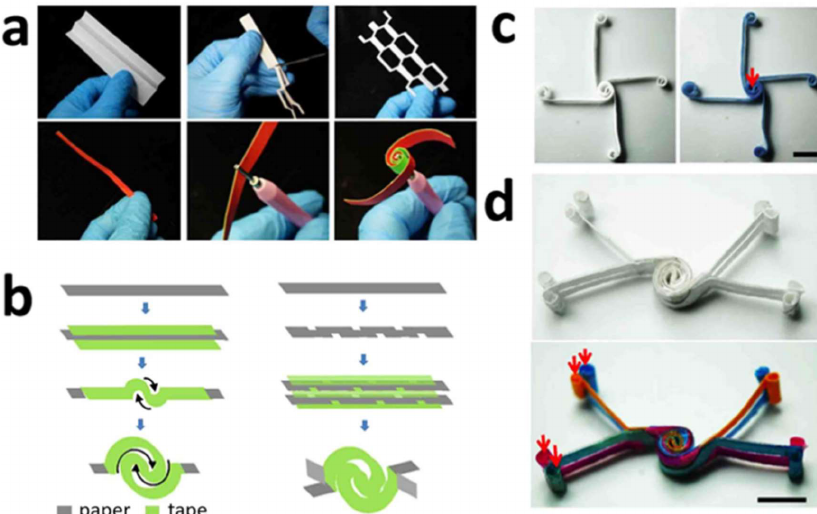
Figure 2. Construction of paper-based devices using origami and kirigami. ( a ) Quilling and kirigami processes are depicted. ( b ) Schematic for the creation of 2D and 3D sensors using origami and kirigami. ( c ) Photographs show 2D sensor before and after the introduction of 0.10 M PBS solution containing 0.010 M coomassie brilliant blue. Solution is introduced at point of red arrow. ( d ) Photographs show 3D sensor before and after the introduction of 0.010 M coomassie brilliant blue, 0.010 M rhodamine B, 0.010 M methyl orange and 0.010 M bromocresol green. Solutions are introduced at points of red arrows. Scale bars represent 10 mm. Reproduced with permission from [26].